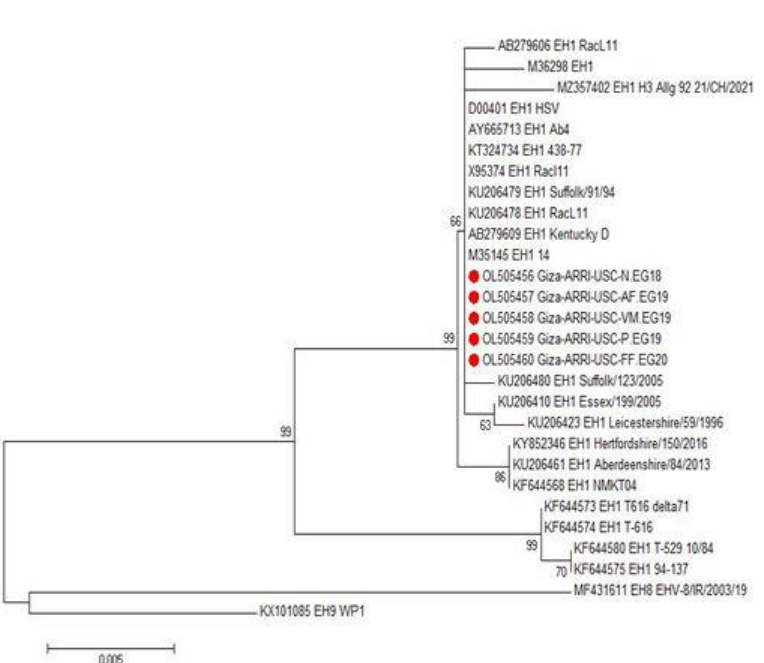
Fig. 4: Phylogenetic tree of the obtained Egyptian EHV-1 isolates.The evolutionary history was created using the maximum likelihood method based on the Tamura-Nei model. The confidence level of the NJ tree was assessed by bootstrapping using 1000 replicates. The cladogram was carried out using the MEGA7 software. The red circles represented the different sequences obtained in this study, while the black diamond referred to the previously uploaded Egyptian